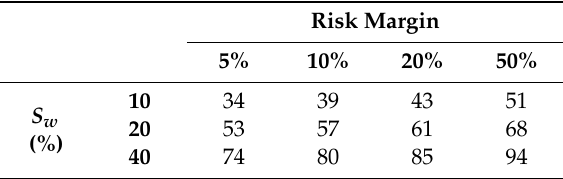
Figure 2. Cumulative distribution functions concerning the probability of 142 stone claddings reaching the end of their service life, considering three risk thresholds. Table 5. Estimated claddings age obtained by the single-parameter stochastic model for different S w values and risk margins.